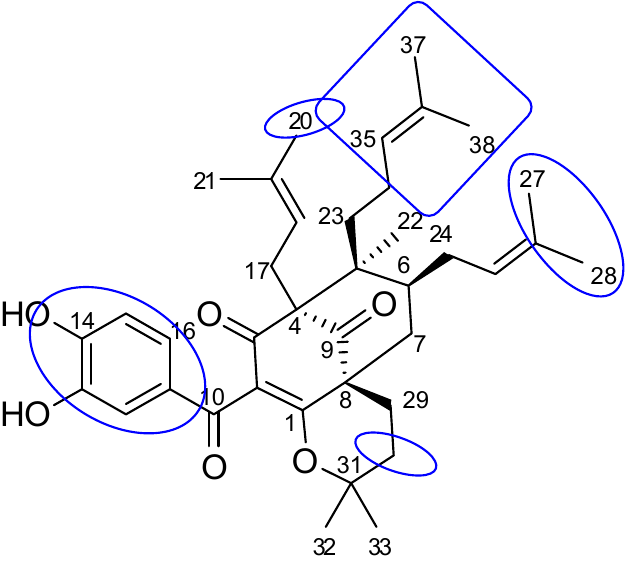
Figure 6. Pharmacophore of pose 148 or compound 1 showing active groups on compound 1 or pose 148.